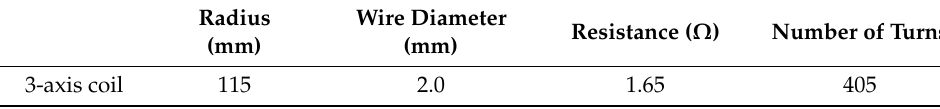
Figure 1. 3D magnetic-force-driven finger rehabilitation device. The installed magnet-array device on the patient’s fingers generates magnetic attractive and repulsive forces by the driving magnetic field in the 3D coil system. Rehabilitation therapy can be performed by assisting the movement of the paralyzed fingers using these magnetic forces. Table 1. Specifications of the three-axis